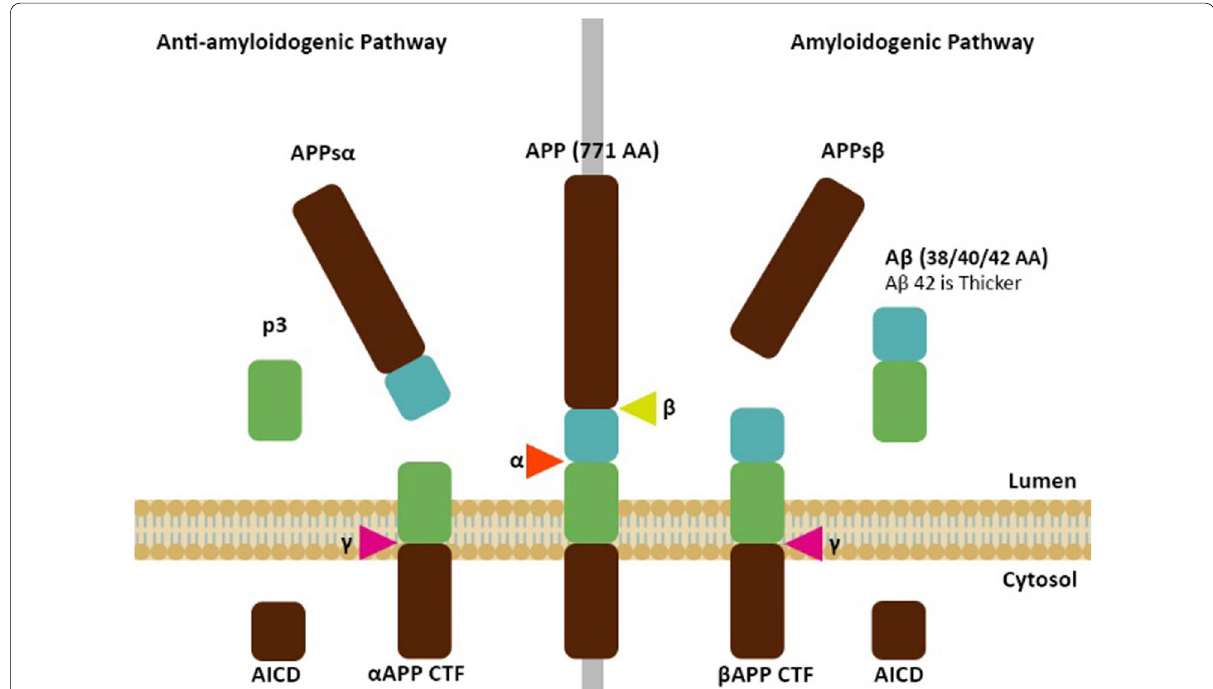
Fig. 2 Amyloid precursor (APP) processing pathway. This diagram shows the proteolysis of Amyloid-beta precursor protein (APP) by the enzymes β-secretase and ɣ -secretase which are responsible for formation of the N and C terminals, respectively. The α-secretase cleaves between the residues 16 and 17 and prohibits the amyloid formation. Therefore, the amyloid-β can be in 40 or 42 amino acid long chain where the 42 amino acid chain is most likely to be